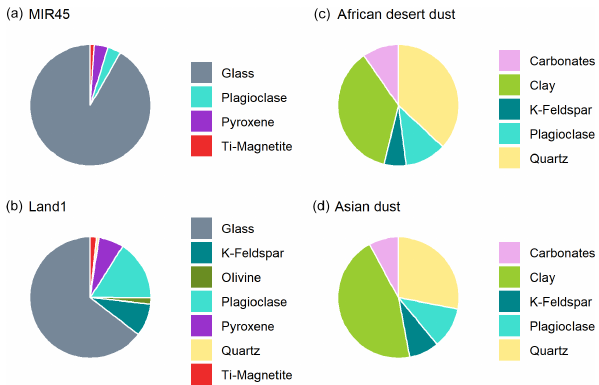
Figure 6. (a–b) Mineralogy of Icelandic dust (MIR45 and Land1; PM 10 ) . (c) Mineral composition of northern African desert dust (PM 20 ), representing the average bulk composition by X-ray diffraction of Tibesti, western Sahara, Niger and Mali samples (Shi et al., 2011b). (d) Mineral composition of Asian dust (PM 10 ); aver- age bulk composition by X-ray diffraction of dust from arid regions in Mongolia and northern China collected in Seoul (South Korea) during eight dust events in 2003–2005 (Jeong et al.,